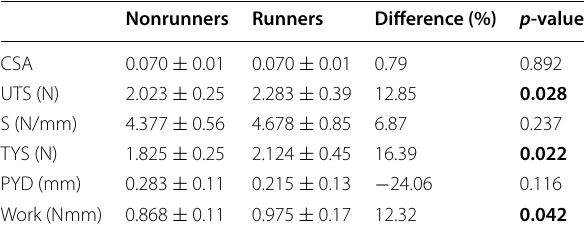
Table 4 Least square means differences in ACL anatomical and mechanical properties between B6 runners and nonrunners